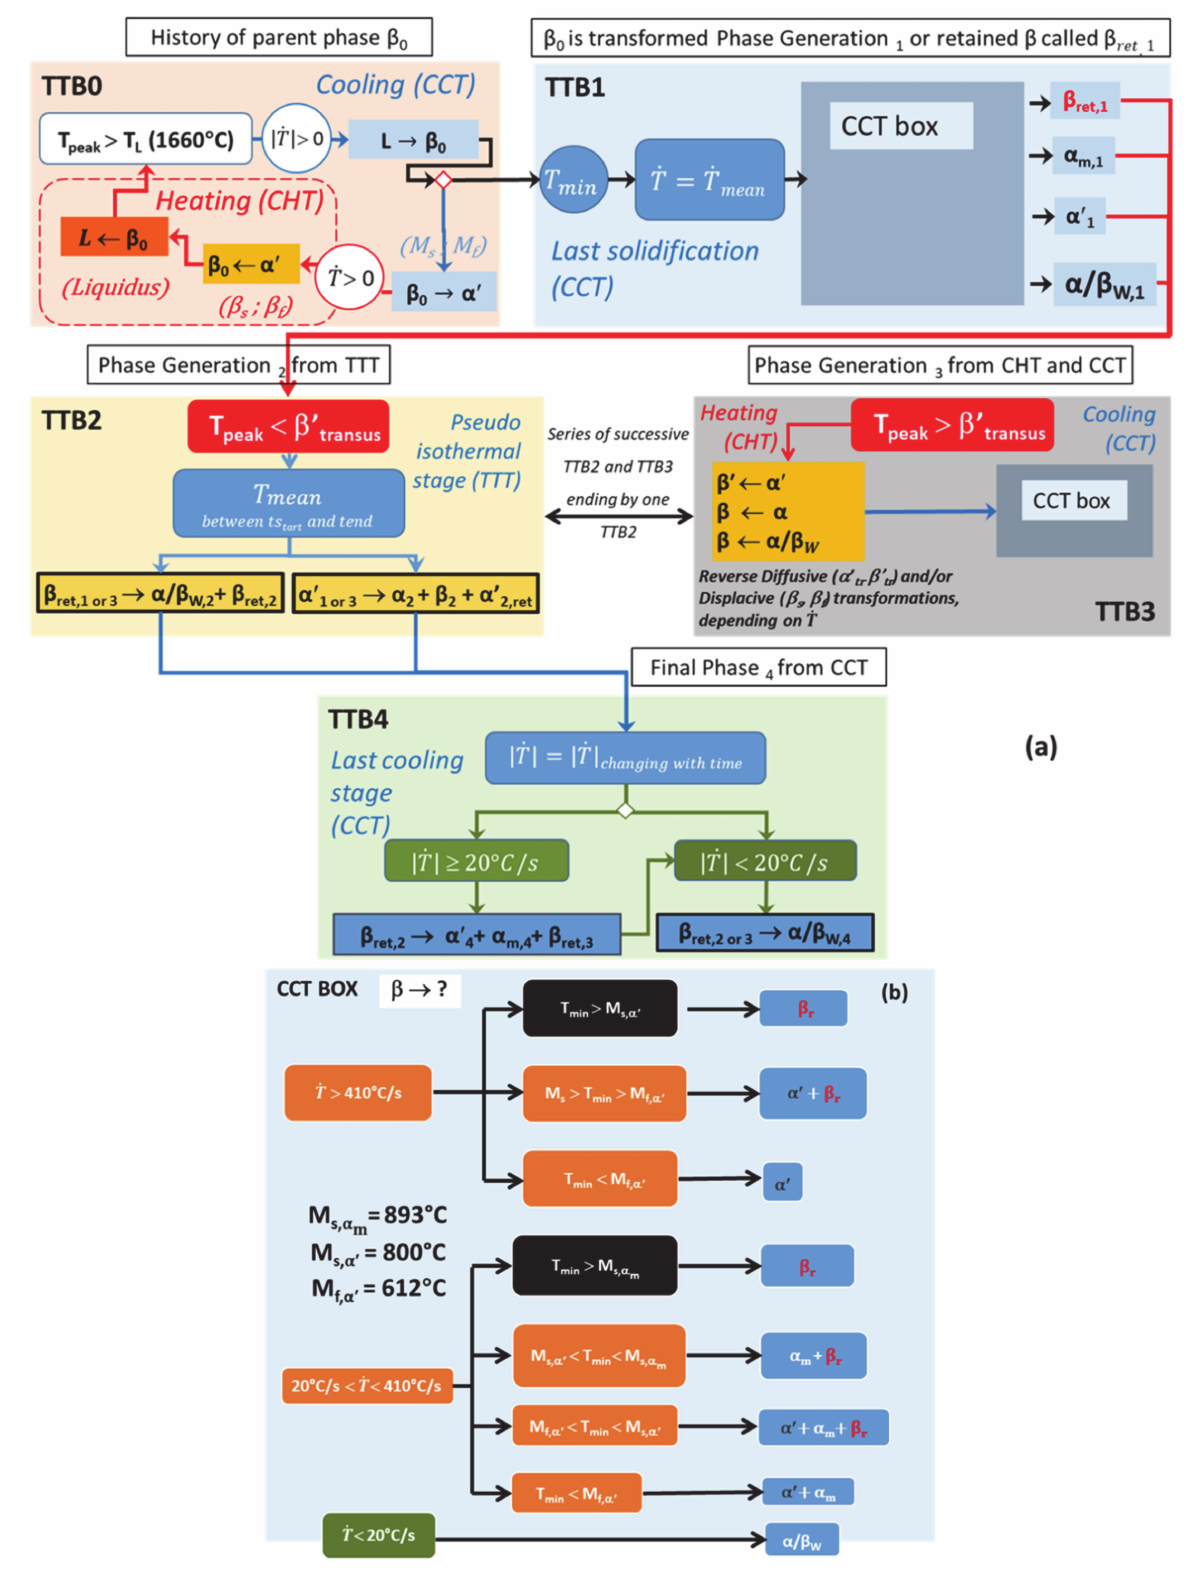
Figure 17. ( a ) General time-transformation-blocks (TTBs) based on thermal histories with related phase transformations occurring during DED; ( b ) highlighting of CCT Box transformations occurring within TTB1 and